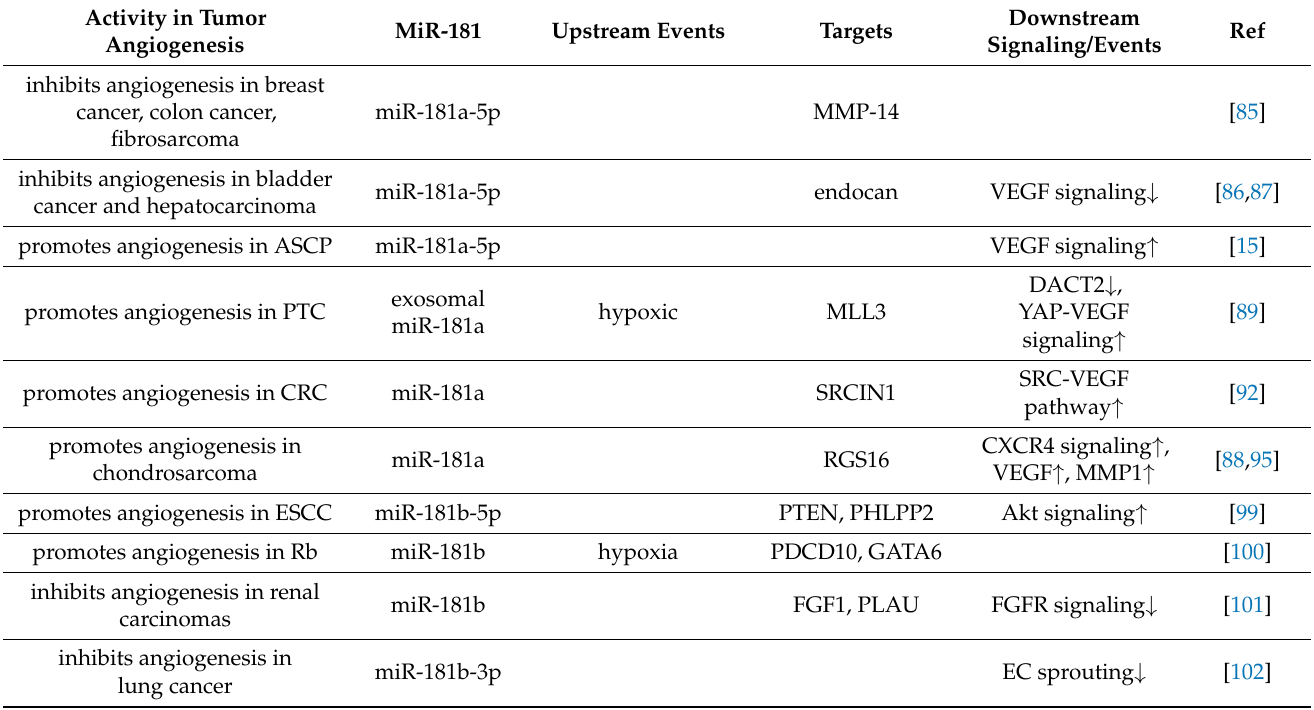
Table 3. Roles of miR-181 in tumor